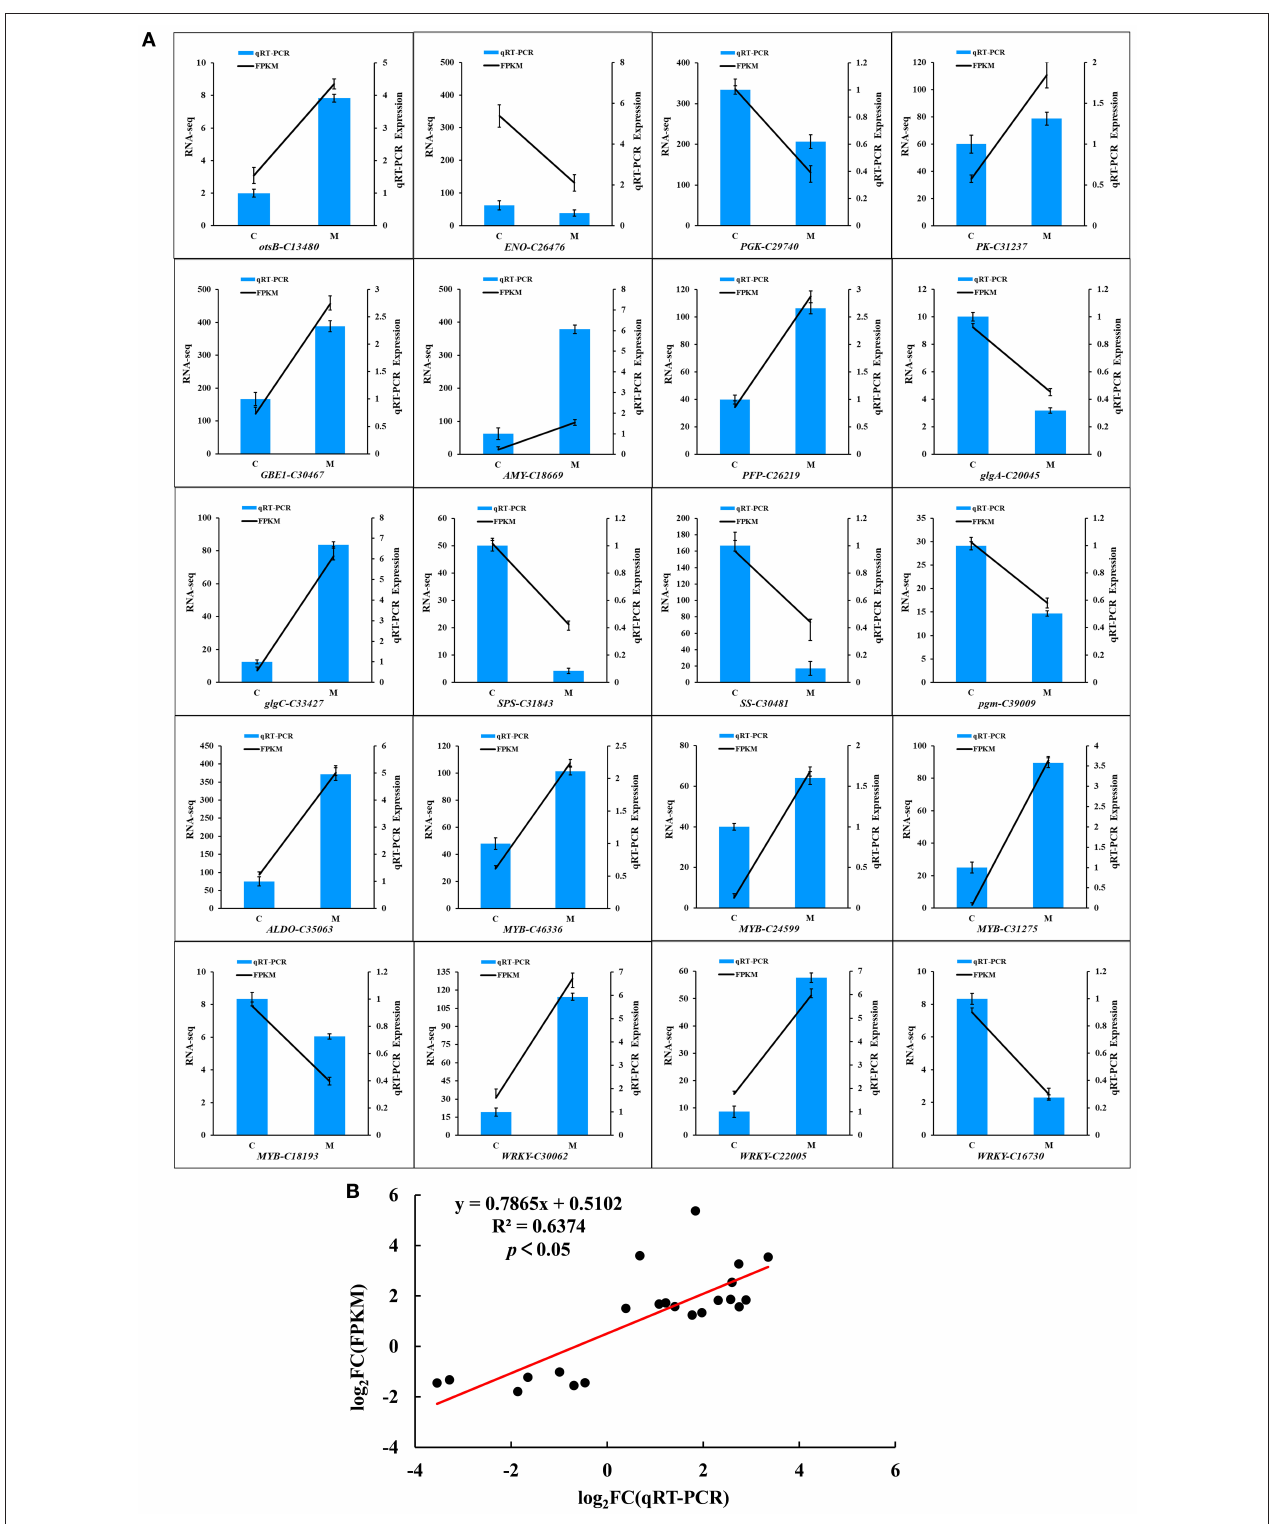
FIGURE 8 | Quantitative Real-Time PCR validation of the 20 candidate genes in M. microcarpa transcriptome. (A) qRT-PCR validation of gene expression level in the transcriptome. The error bars represent the standard error of three biological replicates. Means with different letters in each tissue represent a significant difference at p ≤ 0.05. (B) Correlation analysis of the results between RNA-seq and qRT-PCR. Results were calculated using log 2 fold variation measurements. The R 2 value represents the correlation between the RNA-seq and qRT-PCR results.